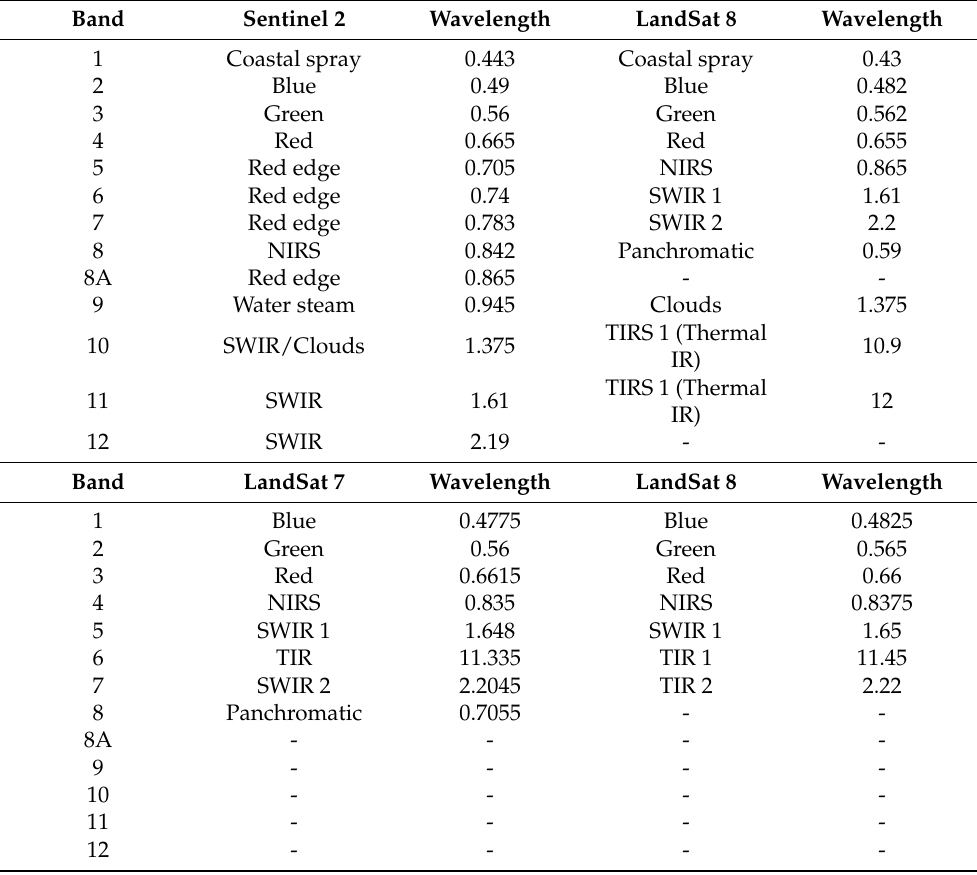
Table A1. Detailed data from the Sentinel 2, LandSat 5, LandSat 7 and LandSat 8 satellites.